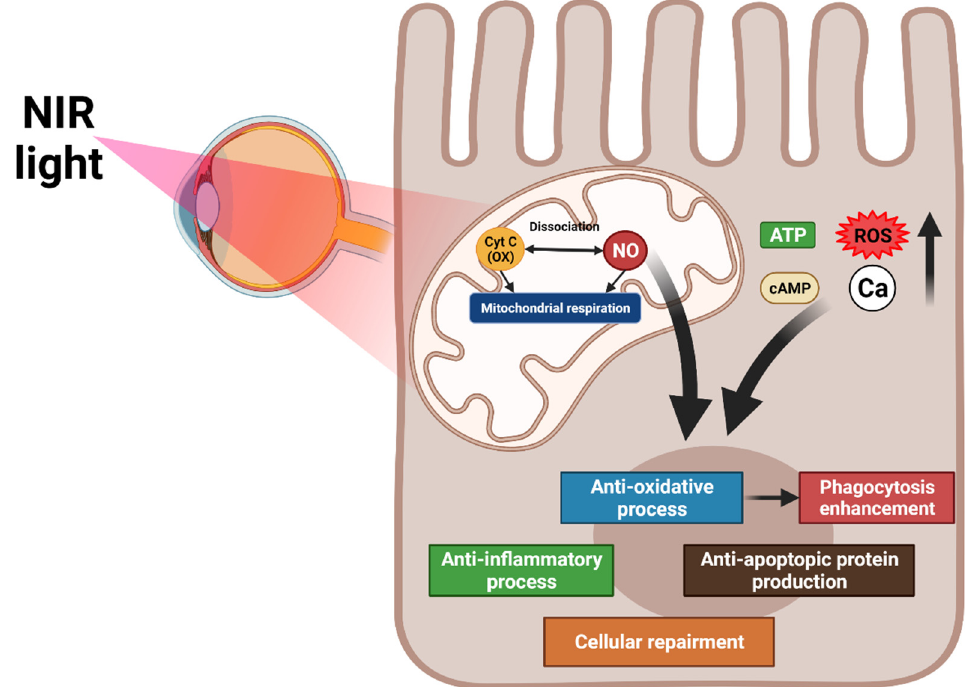
Figure 3. Overview of the mechanisms of photobiomodulation (PBM). PBM activates mitochondrial cytochrome oxidase C and increases mitochondrial respiration and nitric oxide dissociation. These processes elevate ATP, cAMP, reactive oxygen species, and intracellular calcium levels, promoting anti-inflammation, antioxidation, protein synthesis, anti-apoptosis, and cellular metabolism. The antioxidation effect of PBM increases RPE phagocytosis.